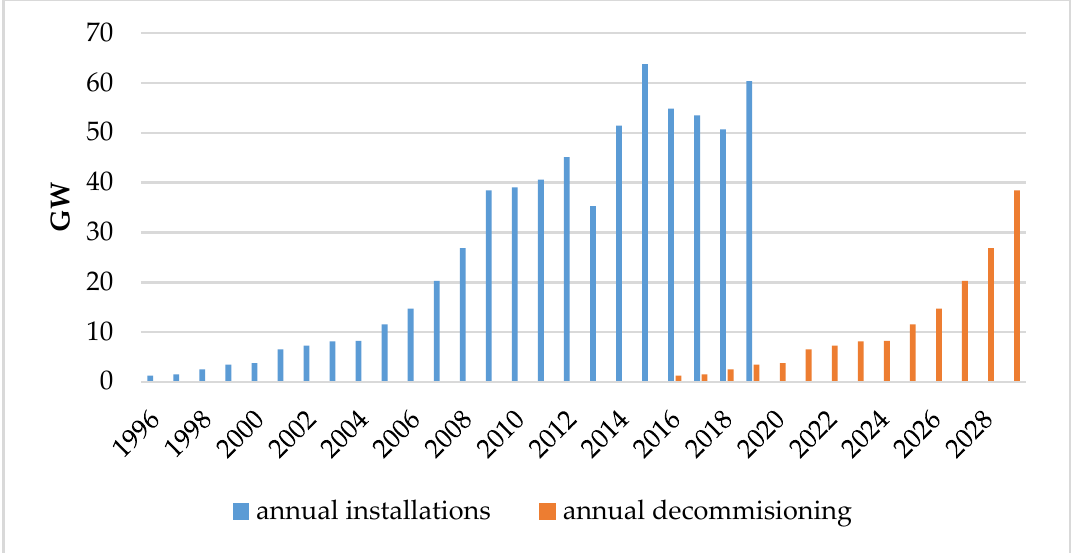
Figure 2. Historical development of annual new wind turbines installations (in GW) and anticipated decommissioning until 2035. Source: based on [26].